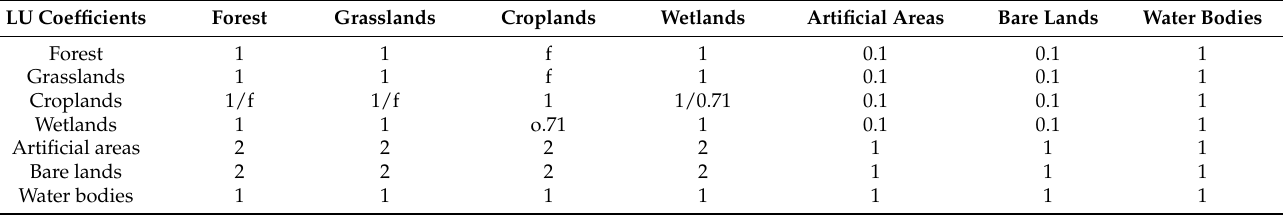
Table A2. Conversion coefficients for changes in land